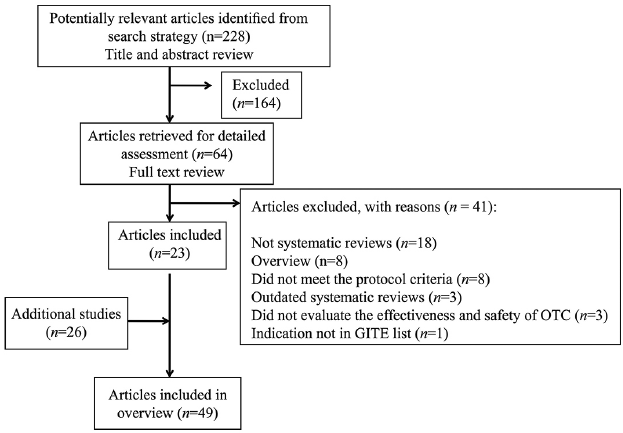
FIGURE 1 - Flowchart for the selection of systematic reviews included in the